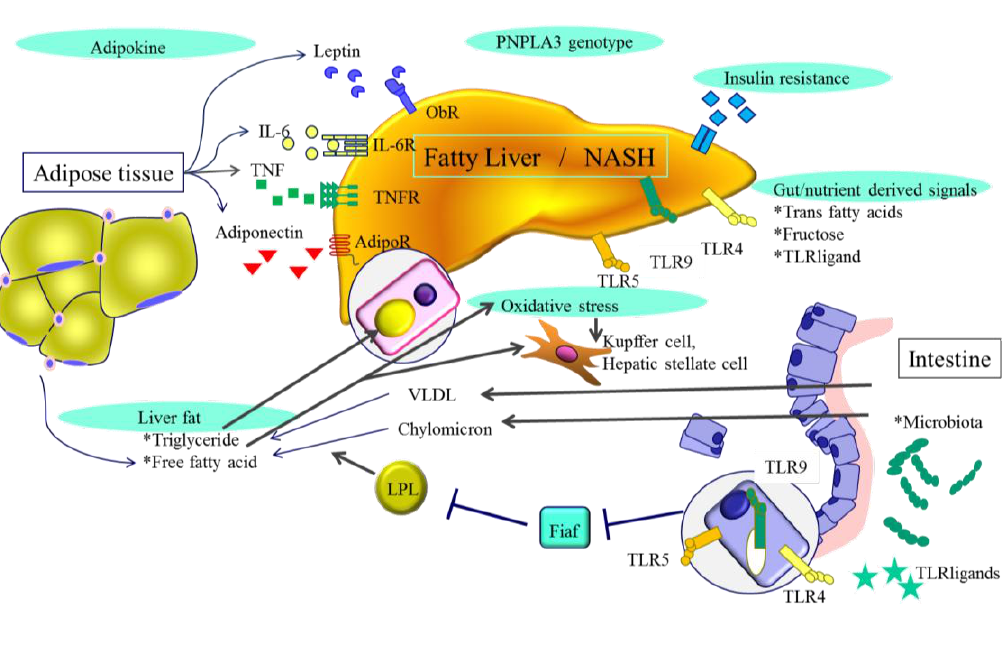
Figure 1. Multiple parallel hit theory. Genome-wide association studies have confirmed importance of patatin-like phospholipase 3 ( PNPLA3 ) gene polymorphism in NAFLD. This genetic polymorphism can differentiate simple steatosis with or without minimal inflammation and fibrosis progressing to NASH. In some instances, inflammation could precede steatosis and anti-tumor necrosis factor (TNF)-α antibody improves steatosis in ob/ob mice. Obesity and diabetes induce insulin resistance, adipocyte proliferation and changes in intestinal flora. Adipokines such as IL-6 and TNF-α produced by adipocytes affect hepatocyte fat content and liver inflammatory environment. Gut-derived signals could be affected by ingested trans fatty acids, fructose, or TLR ligands. Ingested free fatty acids and free cholesterol induce ER stress and oxidative stress resulting in hepatic inflammation and